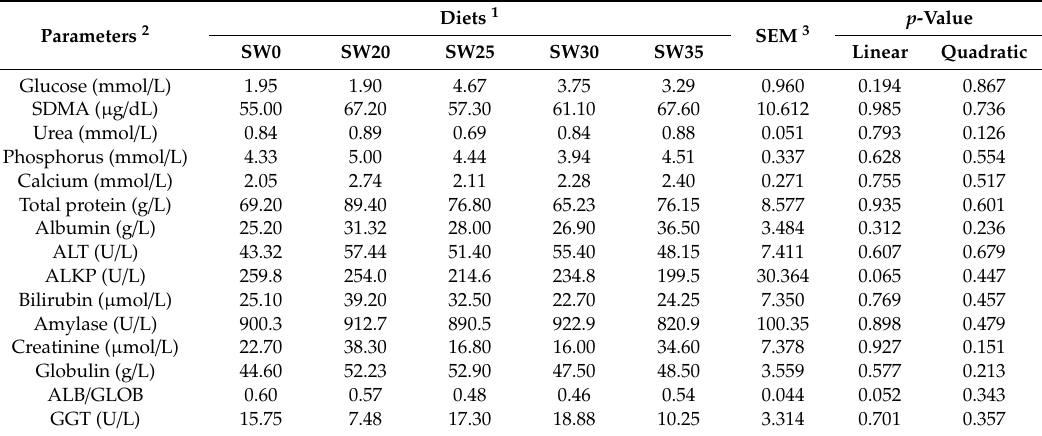
Table 8. Serum biochemical parameters of Boschveld indigenous hens fed diets containing seaweed meal. Parameters